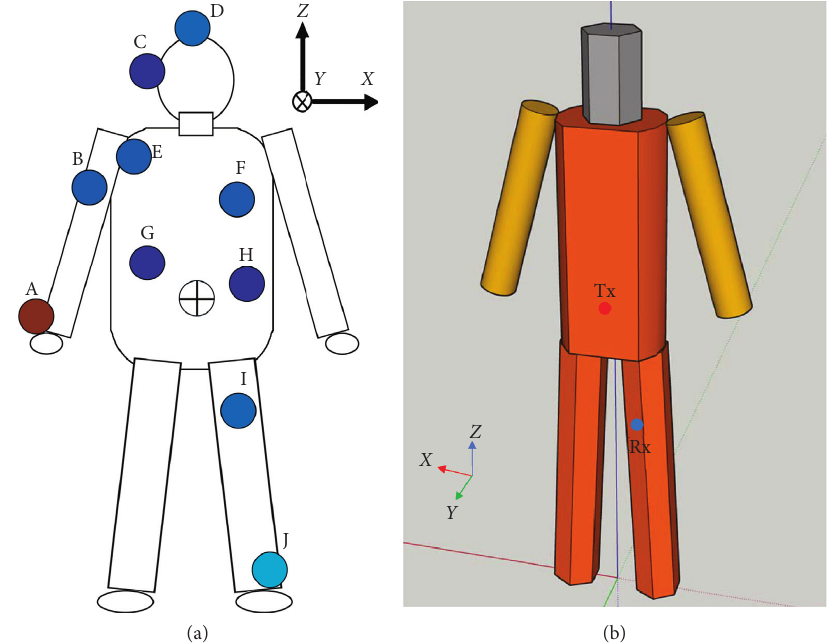
Figure 15: Positions of the Tx and Rx. (a) Measurement position I [25]. (b) Simulation with human body model 1 in Table 14.